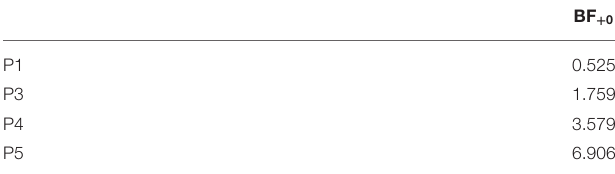
TABLE 5 | Bayesian paired samples t tests (H1 B ) on subject